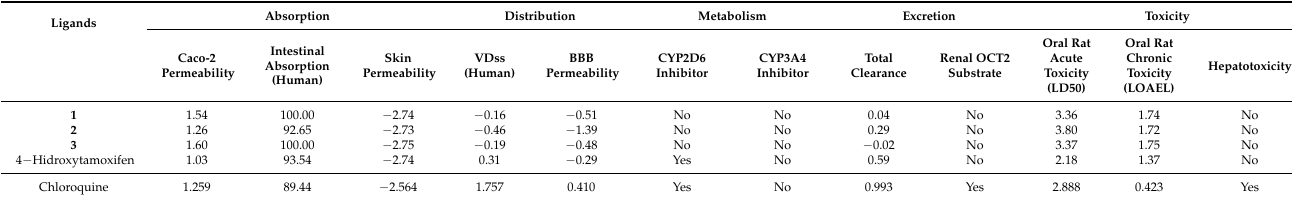
Table 8. ADMET properties by the pkSCM online